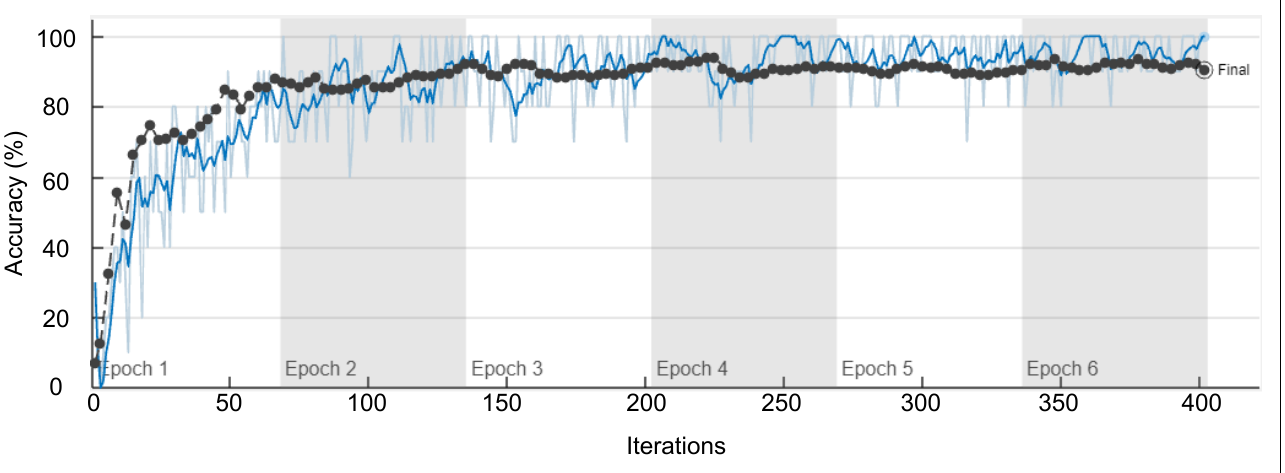
Figure 13. Classification of Buttercup image before and after encryption.